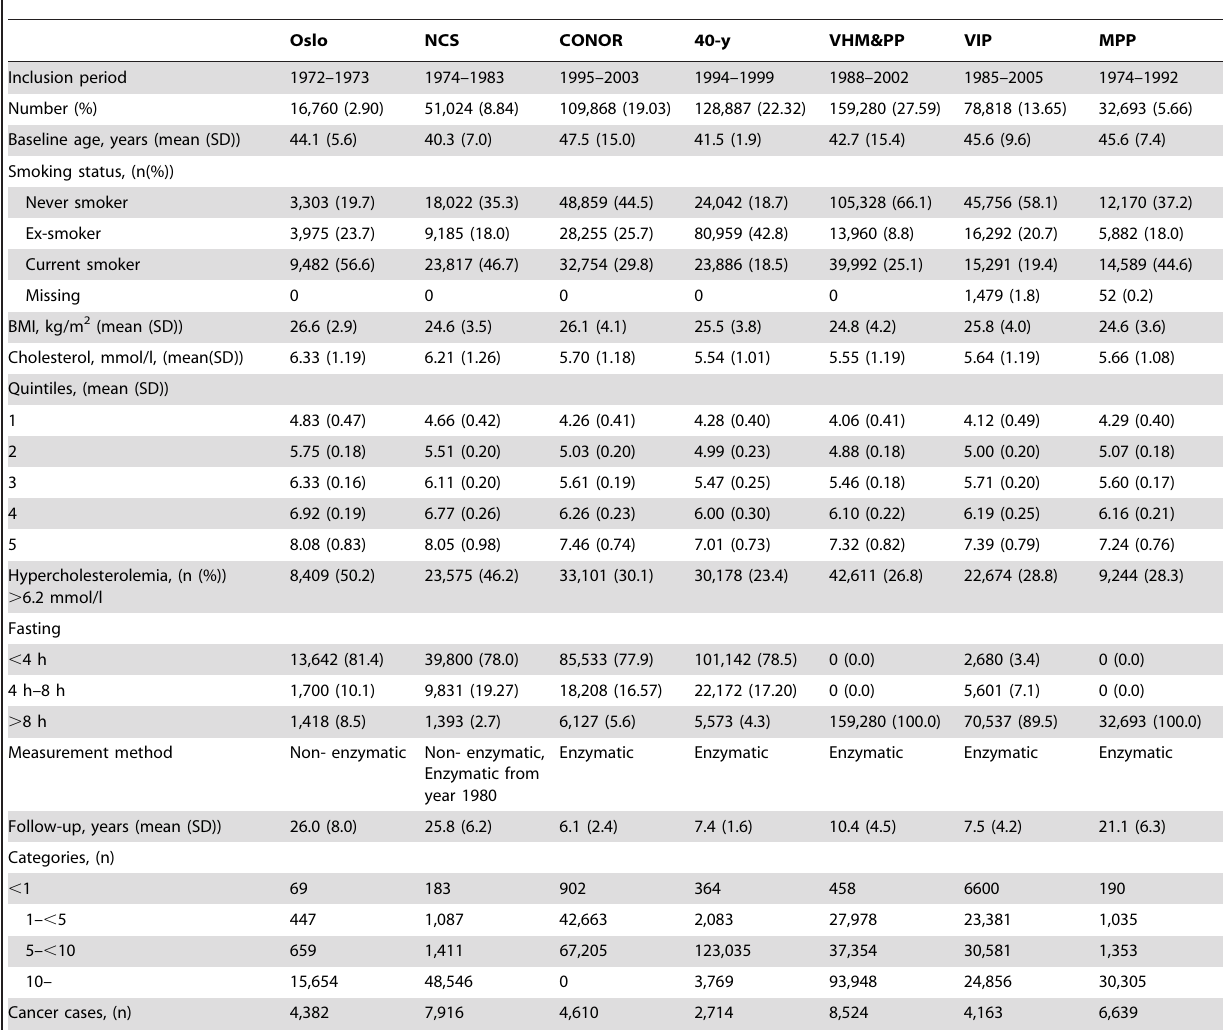
Table 1. Baseline characteristics of study participants in the Metabolic Syndrome and Cancer